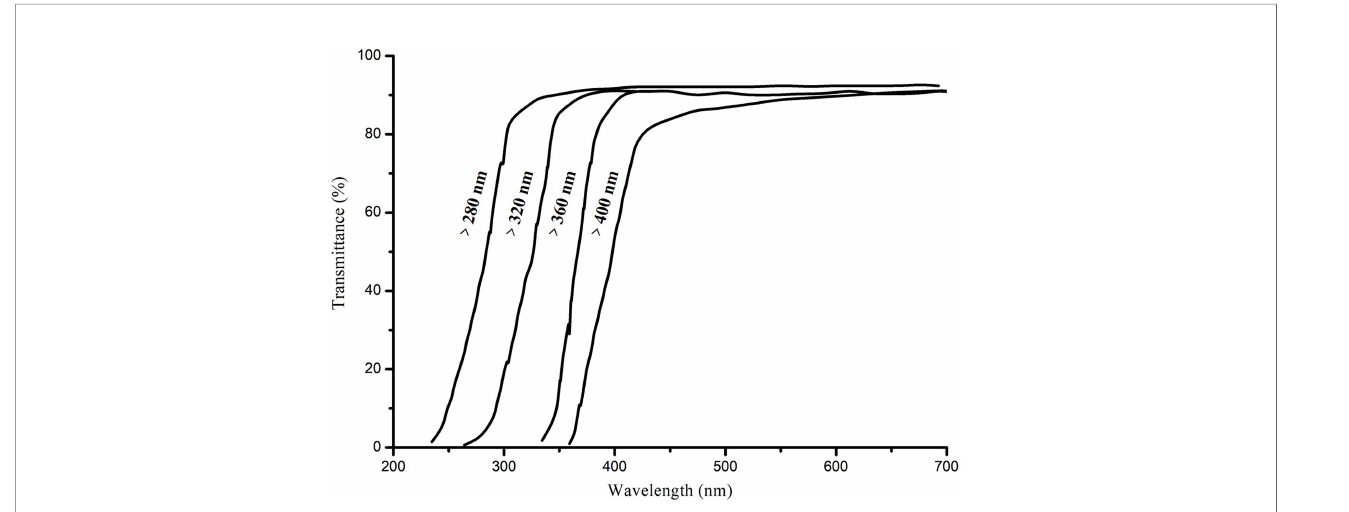
FIGURE 1 | Transmittance spectra of different ultraviolet fi